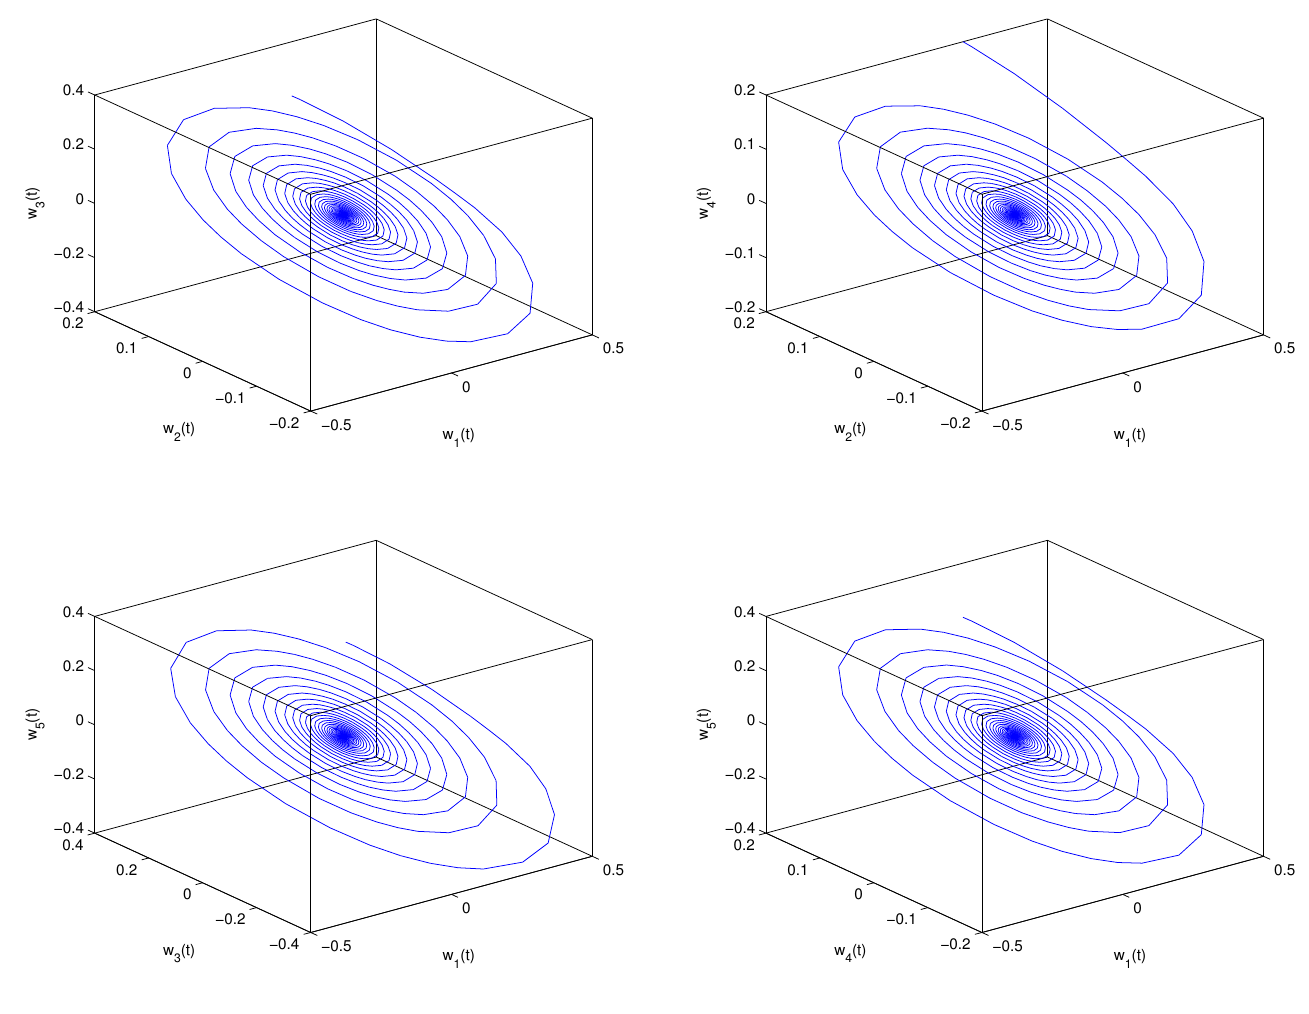
Figure 8. Matlab simulation results for system (72) when ϑ = 0.42 < ϑ ∗ = 0.44. The null equilibrium